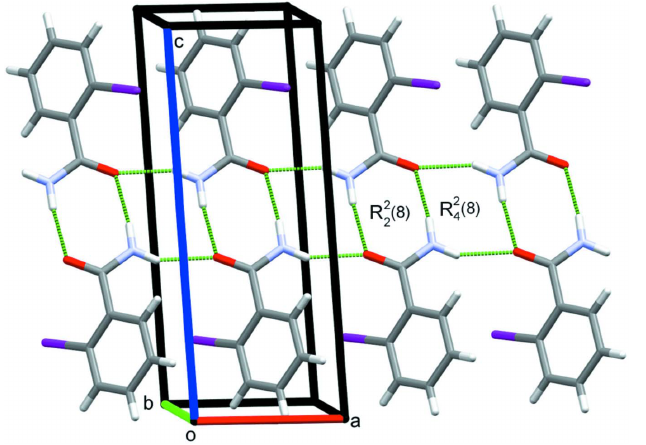
(Table 2), in this instance also supported by C6—H6 (cid:2) (cid:2) (cid:2) Cg 2